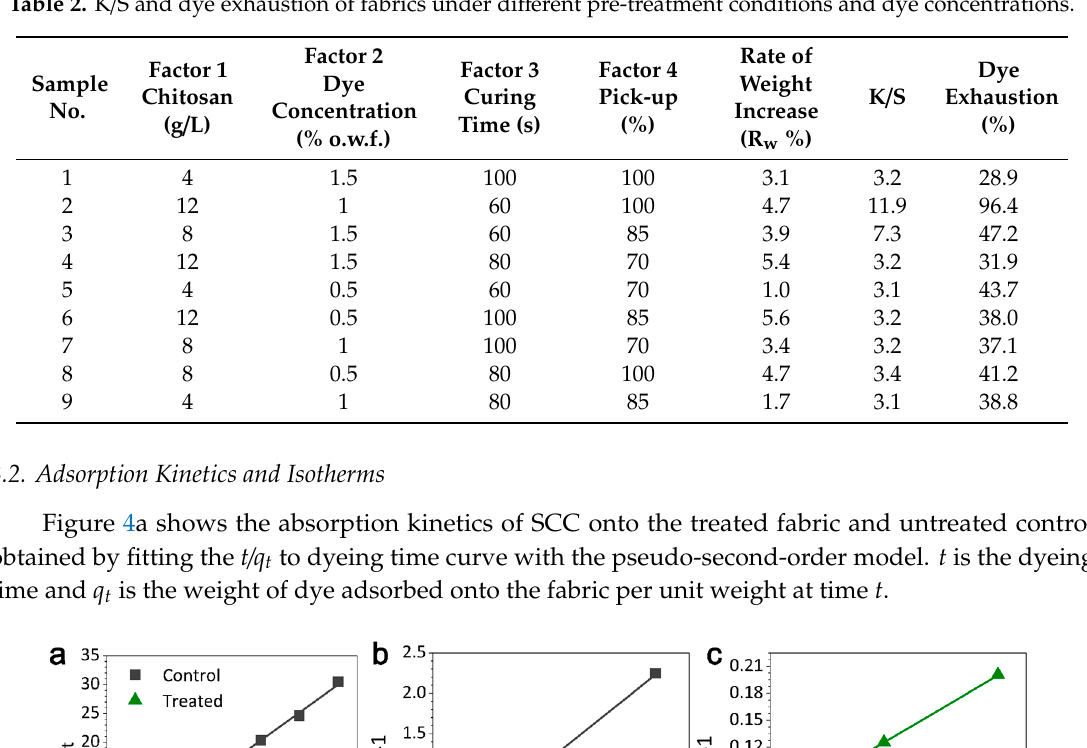
Table 2. K / S and dye exhaustion of fabrics under di ff erent pre-treatment conditions and dye concentrations.